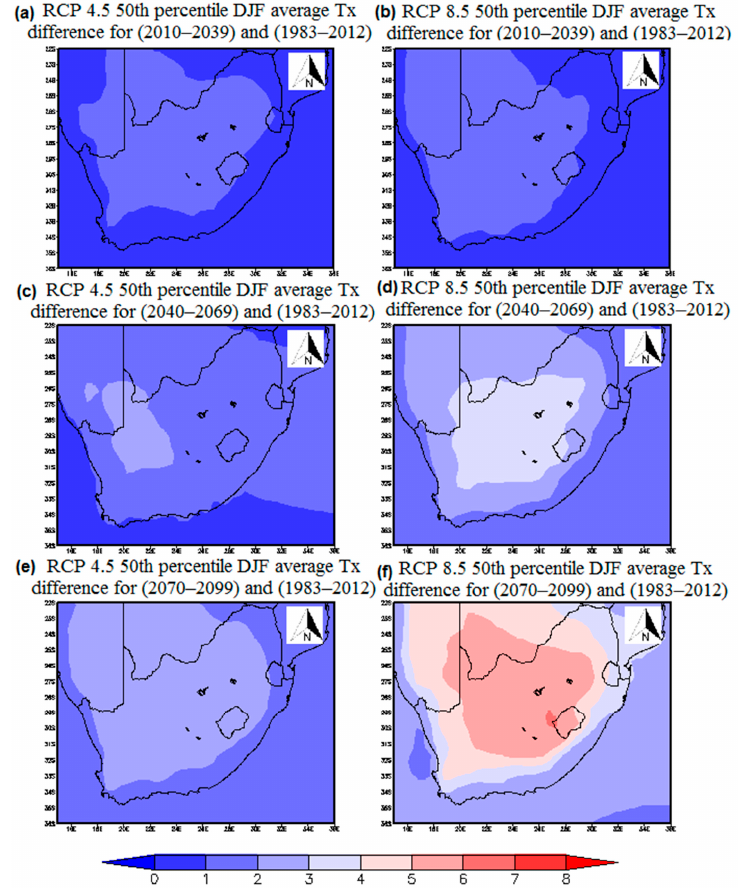
Figure 3. Simulations of DJF average Tx (°C) 50th percentile differences of average Tx (°C) difference between 1983 and 2012 with future climates: ( a ) 2010–2039 RCP 4.5, ( b ) 2010–2039 RCP 8.5, ( c ) 2040–2069 RCP 4.5, ( d ) 2040–2069 RCP 8.5, ( e ) 2070–2099 RCP 4.5 and ( f ) 2070–2099 RCP